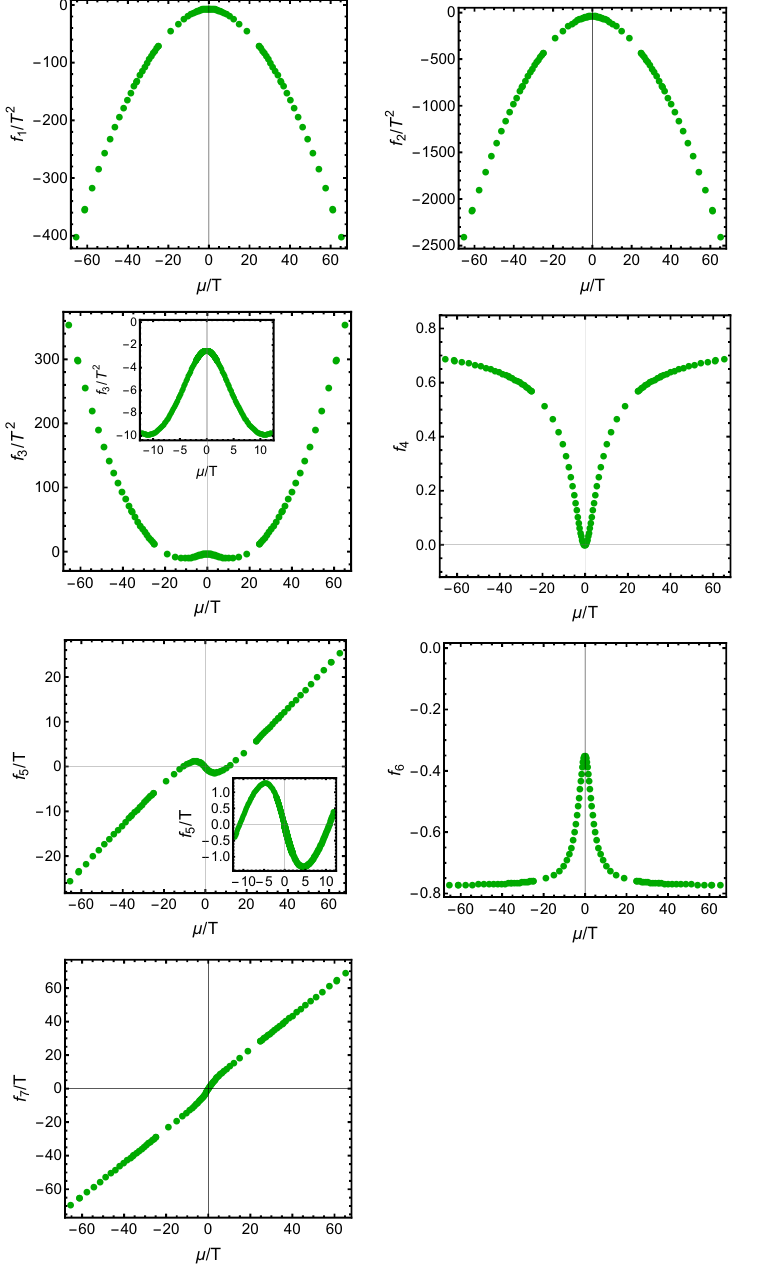
Figure 1 . Susceptibilities f 1 , . . . f 7 for strongly coupled N = 4 SYM as functions of the dimension- less parameter µ/T . The insets for f 3 , f 5 depict zoomed-in behaviour in the vicinity of the